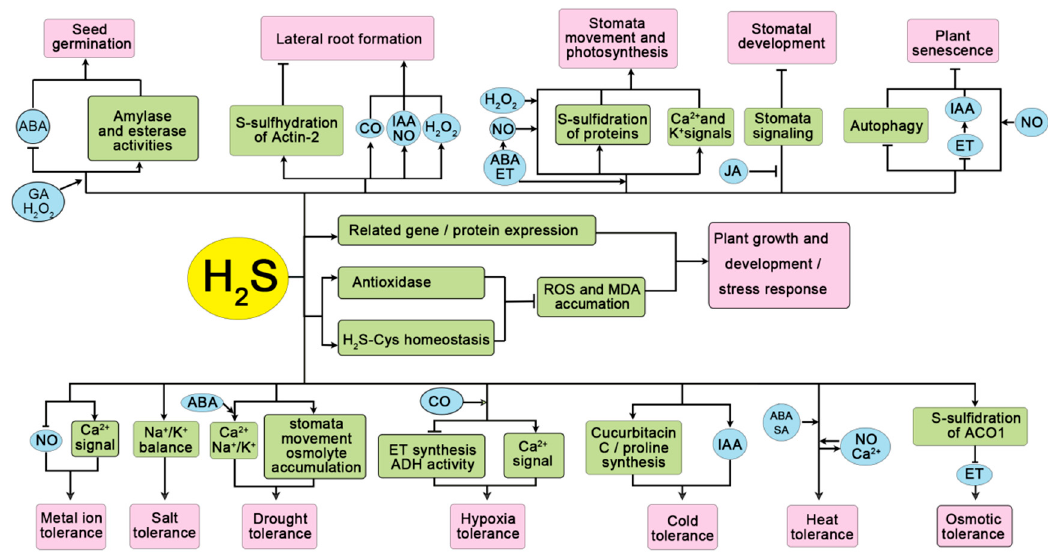
Figure 2. A model of the roles of H 2 S in plant development and stress responses. H 2 S has recently been recognized as a novel gaseous signaling molecule with various functions during plant development at di ff erent stages and during stress responses. H 2 S functions by promoting the expression of specific genes, enhancing the activity of the antioxidant system and maintaining H 2 S-Cys homeostasis. Growing evidence suggests that H 2 S is involved in seed germination, by increasing amylase and esterase content for greater energy e ffi ciency. H 2 S can also fine-tune lateral root formation, stomatal movement, photosynthesis, and plant senescence by regulating protein S-sulfhydration and by establishing crosstalk with CO, NO, IAA, ABA, ET, and other signaling pathways. In addition, H 2 S may also be involved in plant senescence by inhibiting autophagy. Both exogenous and endogenous H 2 S are able to optimize plant adaptation to various stresses (e.g., metal ion, drought, hypoxia, temperature, salt, and osmotic stress) through positively regulating ionic equilibrium, stomatal movement, osmolyte accumulation, ethylene synthesis, related enzyme activity, interaction with other reactive species, and plant hormones. H 2 S can also regulate the expression of related genes and proteins, reduce the oxidative stress caused by various stresses by enhancing the activities of antioxidant enzymes and the accumulation of antioxidants, so as to improve the stress resistance and promote plant development.